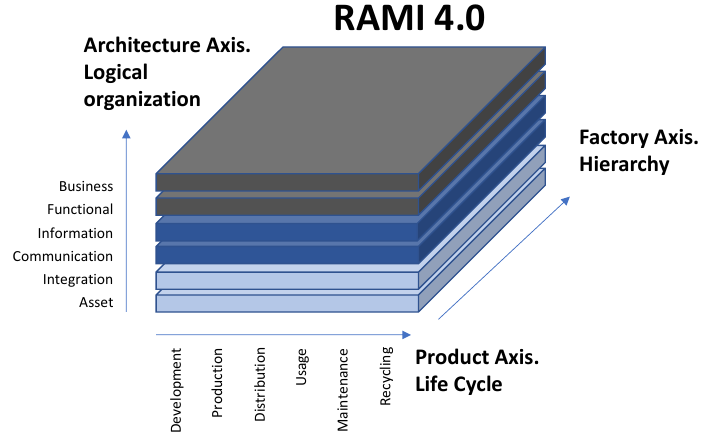
Figure 7. RAMI 4.0 oveview